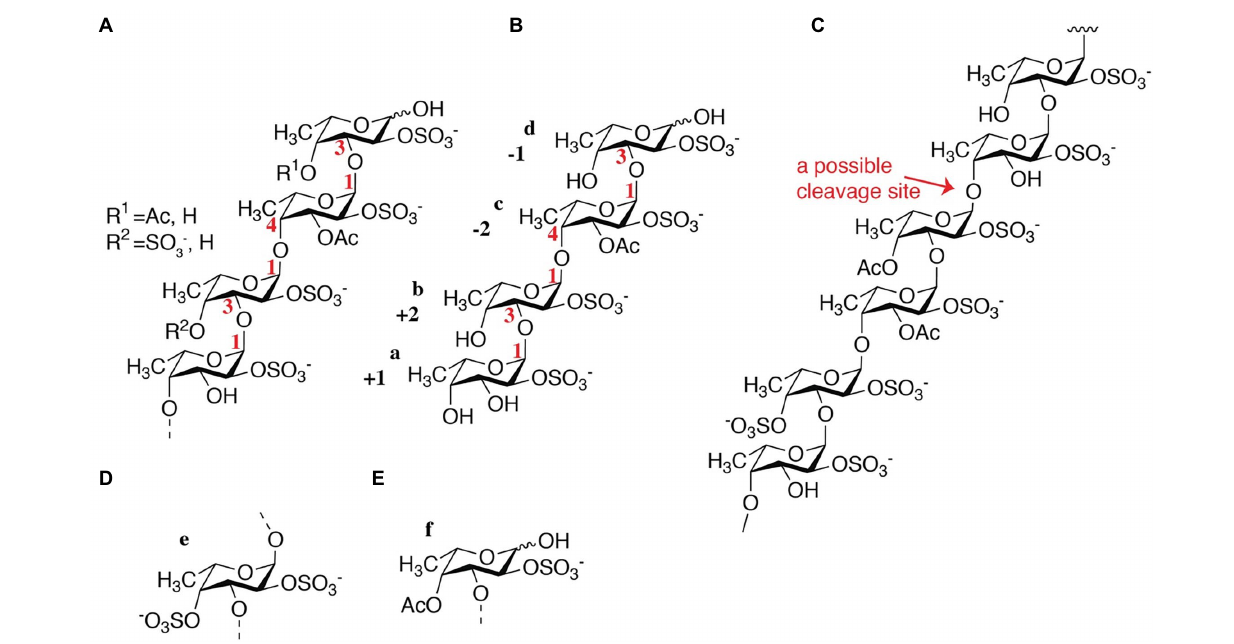
TABLE 1 | The 1 H and 13 C NMR data for main structure (containing A, B, C, D units) oligosaccharide and variously substituted units (E, F) in the Fhf2 Δ 484-derived LMWF fraction ( δ 1 H/ 13 C,